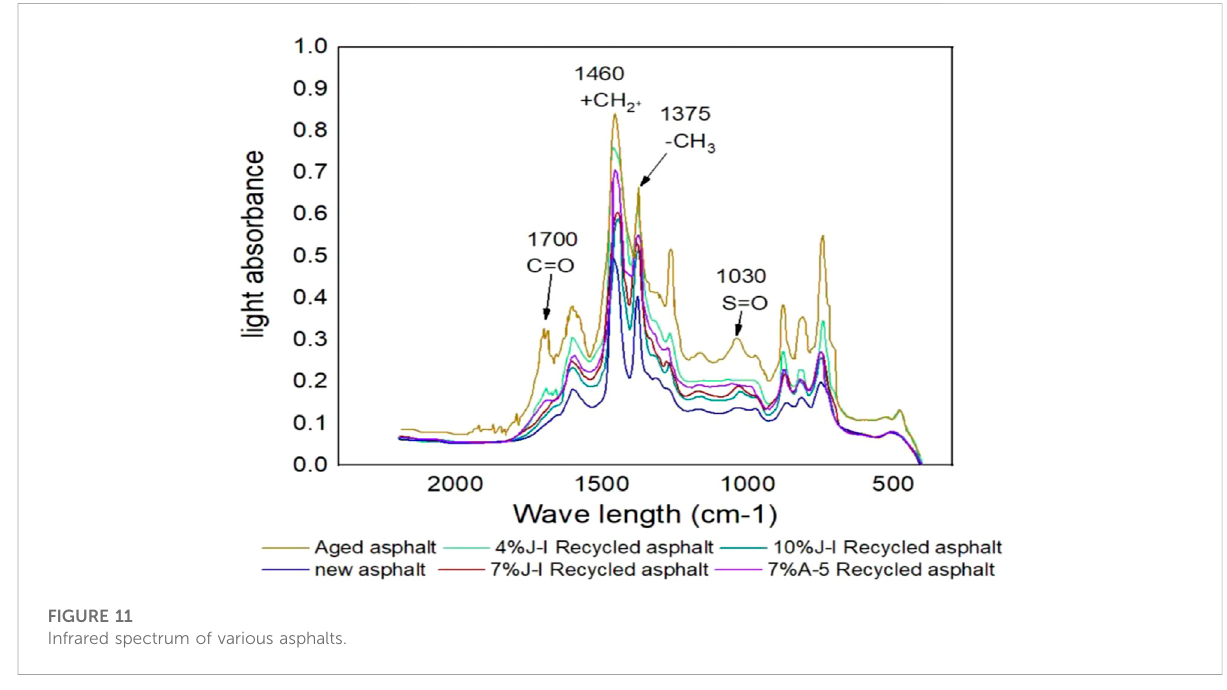
FIGURE 11 Infrared spectrum of various asphalts.